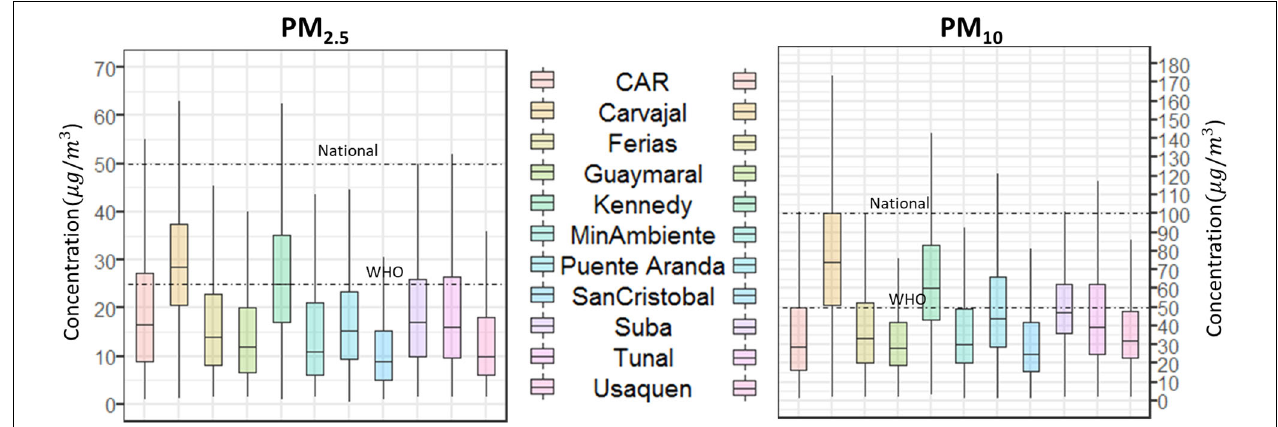
FIGURE 8 | Boxplots of PM 2 . 5 (left chart) and PM 10 (right chart) measured concentrations (valid data only), depicting the median as the center value, quantiles 75 and 25% for limits of the box, and the upper/lower whiskers being the largest/smallest measurement within 1.5 times the inter-quartile range.